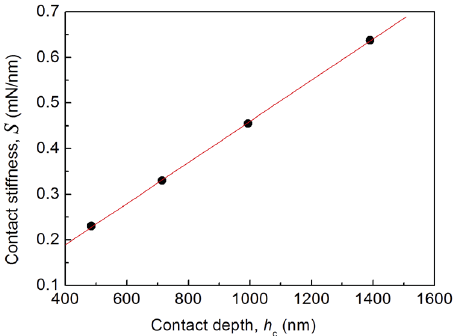
Fig. 3 Relationship between the contact stiffness S and the contact depth h c . The solid line is obtained by regression analysis of the experimental data.